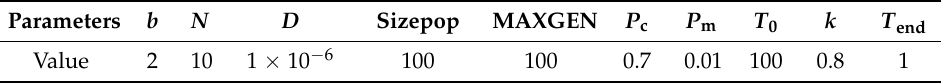
Table 4. Controlling parameters of the SAGA-FCM